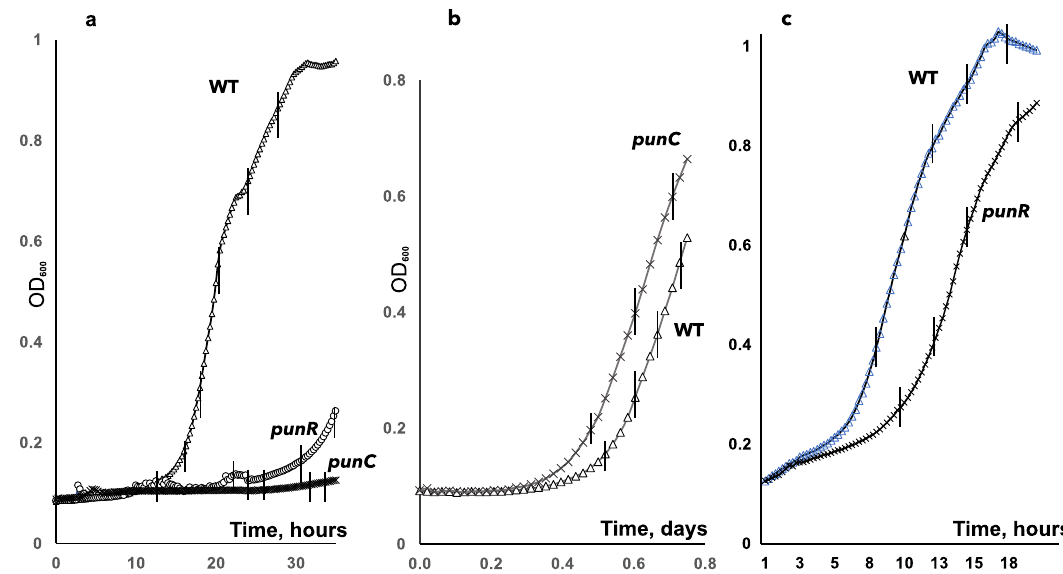
Fig. 5 Growth phenotypes of the punR and punC knockout strains in M9 medium. Growth phenotypes of the punR and punC knockout strains in M9 medium with 0.2% glucose as the sole carbon source and a 2.5 mM adenosine as the sole nitrogen source, b NH 4 Cl as the nitrogen source. The growth of the punR (O) and punC (X) deletion strains compared to the wild-type E. coli BW25113 ( Δ ) strain. c Growth of E. coli MG1655 wild-type ( Δ ) and punR (O) deletion strain in the same medium as in ( a